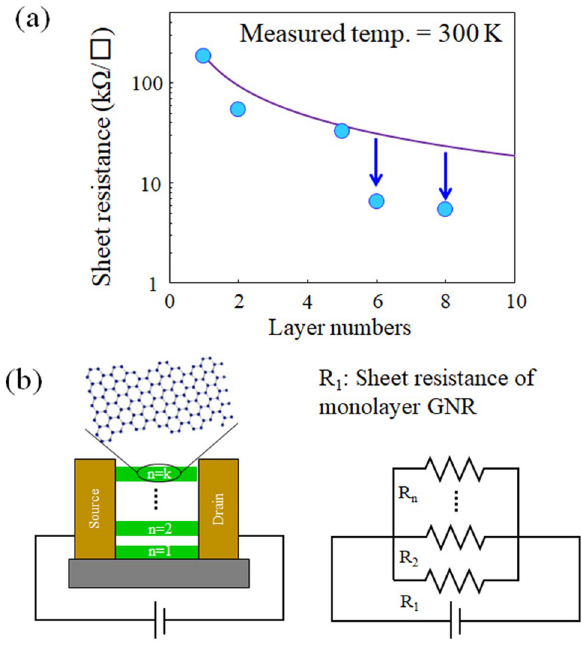
Figure 4. ( a ) Sheet resistance measured at ON state region vs the number of layers in the GNR-FET. ( b ) Is a resistance model composed of parallel channel, assuming that the conductance between layers can be